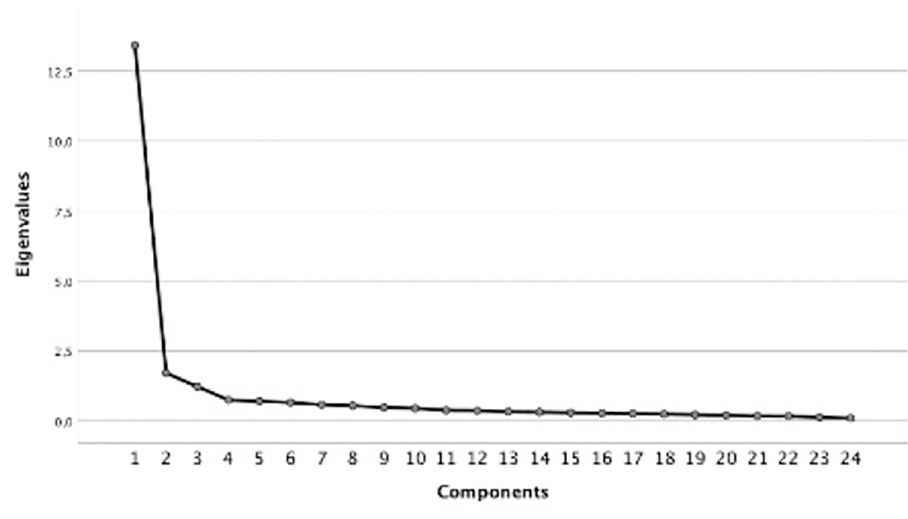
Fig 2. Scree-plot of exploratory factor